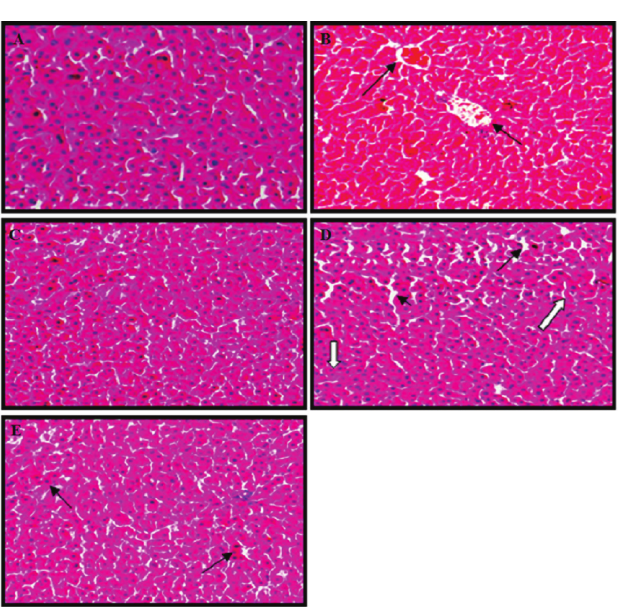
FIGURE 4 - Photomicrographs of effect of different treatments on liver architecture. A= liver of rats in control group showing normal hepatocytes architecture. B = photomicrograph of rat liver of diabetic group showing cell necrosis along with lymphocytes infiltration and sinusoidal dilation with the help of arrows. C = photomicrograph of rat liver in glibenclamide group showing almost same morphology as normal group with normal hepatocytes architecture. D = photomicrograph of rat liver in AESO 250 group showing improved hepatocyte architecture with mild sinusoidal dilation and minimal necrosis. Black arrows are showing sinusoidal dilations while white bold arrows are depicting improved hepatocyte architecture. E = photomicrograph of rat liver in AESO 500 group showing normal hepatocytes same as normal control with lobular regeneration (H & E stain, X20 & 40).